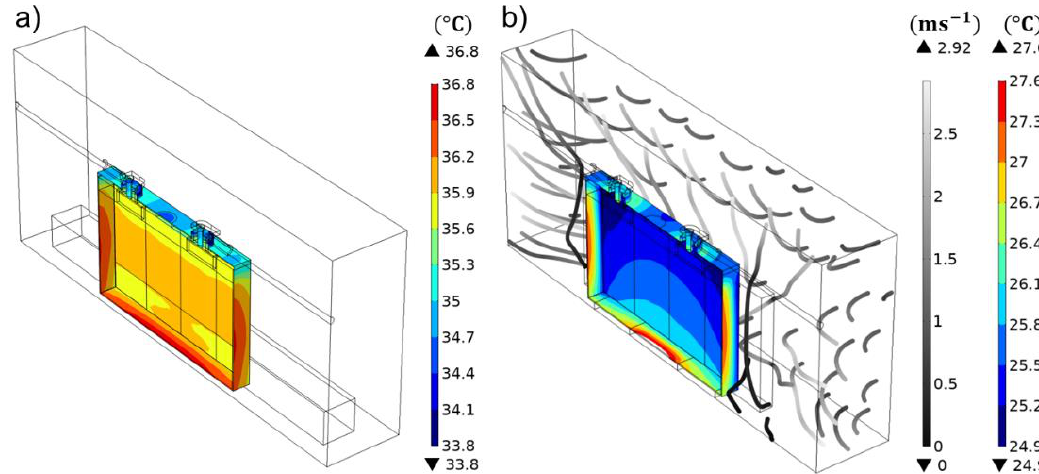
Figure 9. ( a ) Simulated battery surface temperature distribution ϑ ( ◦ C ) during the natural convection scenario and ( b ) simulated battery surface temperature distribution ϑ ( ◦ C ) and velocity streamlines at an inlet velocity of 𝑉 𝑖𝑛 = 1 m s −1 , both shown at a current rate of 2 C at the end of discharge.